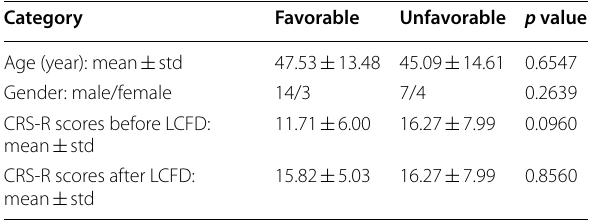
The patients were classified into two categories: “favorable” indicates patients whose CRS-R scores increased after LCFD and whose consciousness levels improved after LCFD, and “unfavorable” indicates patients whose CRS-R scores did not improve after LCFD. For more information about the CRS-R scores and the diagnosis of the states of consciousness, see Additional file 1: Table S1